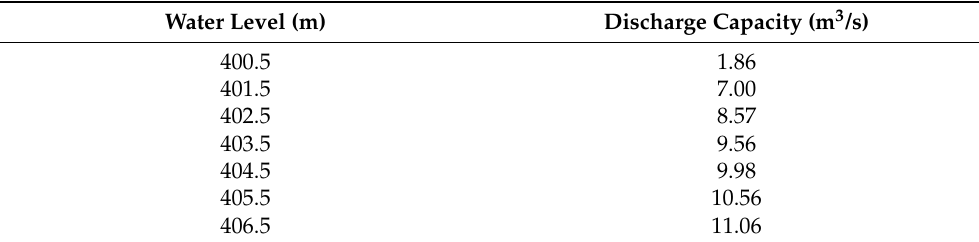
Table 5. Table on results of final discharge capacity within well